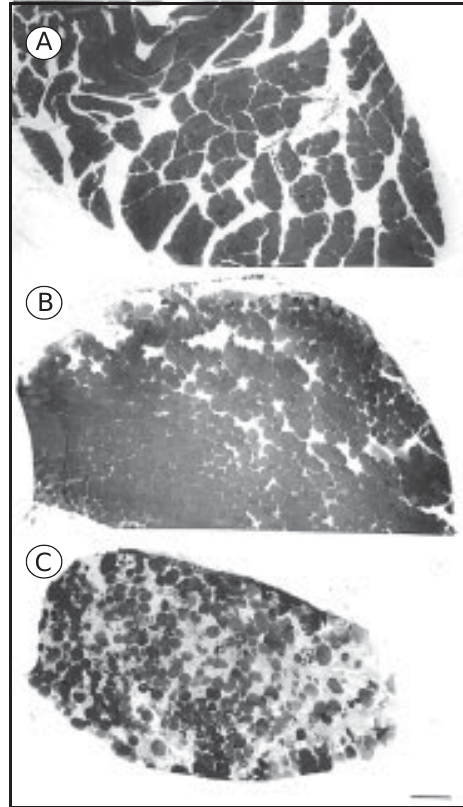
Figure 2. Transverse sections of extensor digitorum longus muscle 4 h after receiving A : 50 µl NaCl injections, B : 0.25 µg/g of venom, and C : 2.0 µg/g of venom. A , Panoramic view of control muscle showing normal cells and organization. In B note the lesion of peripheral muscle fibers and the disorganization of the bundles. In C note the com- plete degeneration of muscle fi- bers (bar = 110